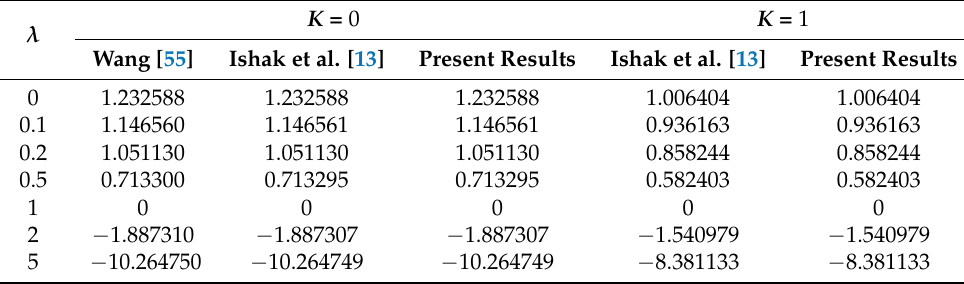
Table 3. Values of f (cid:48)(cid:48) ( 0 ) when λ ≥ 0, ϕ = M = 0, and n = 0.5 for K = 0 and K = 1.